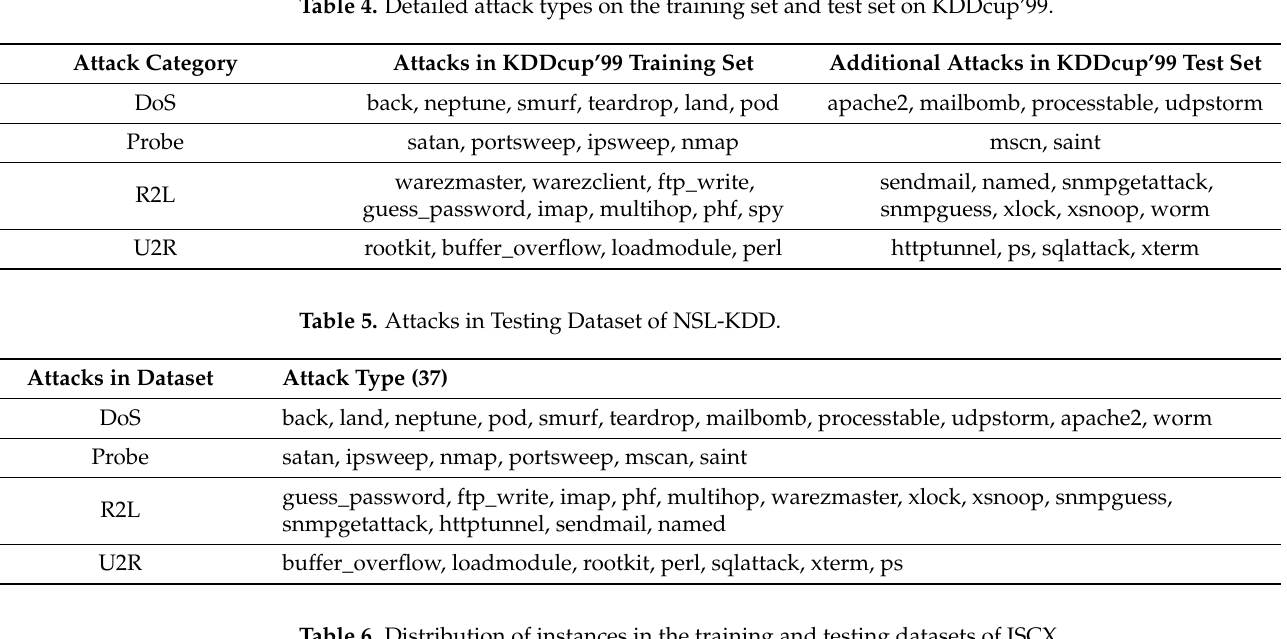
Table 6. Distribution of instances in the training and testing datasets of